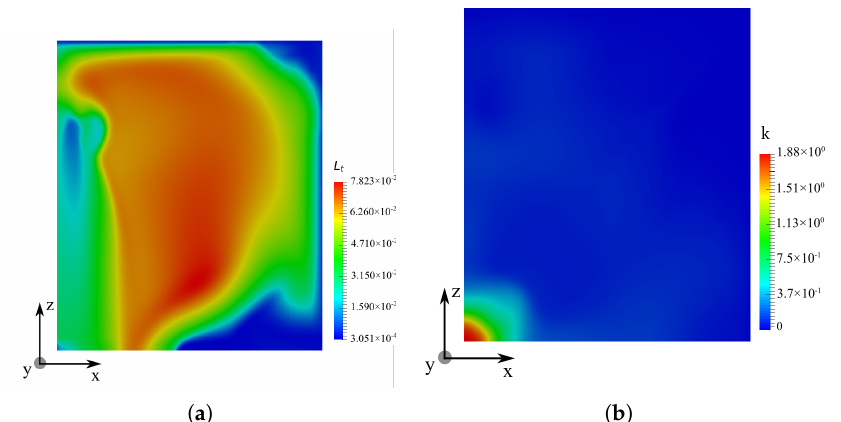
Figure 10. ( a ) Turbulent integral length scale L t (m) on the XZ plane at y = 0.05 m; ( b ) turbulent kinetic energy k (m 2 /s 2 ) on the XY plane at h = 1.5 m.